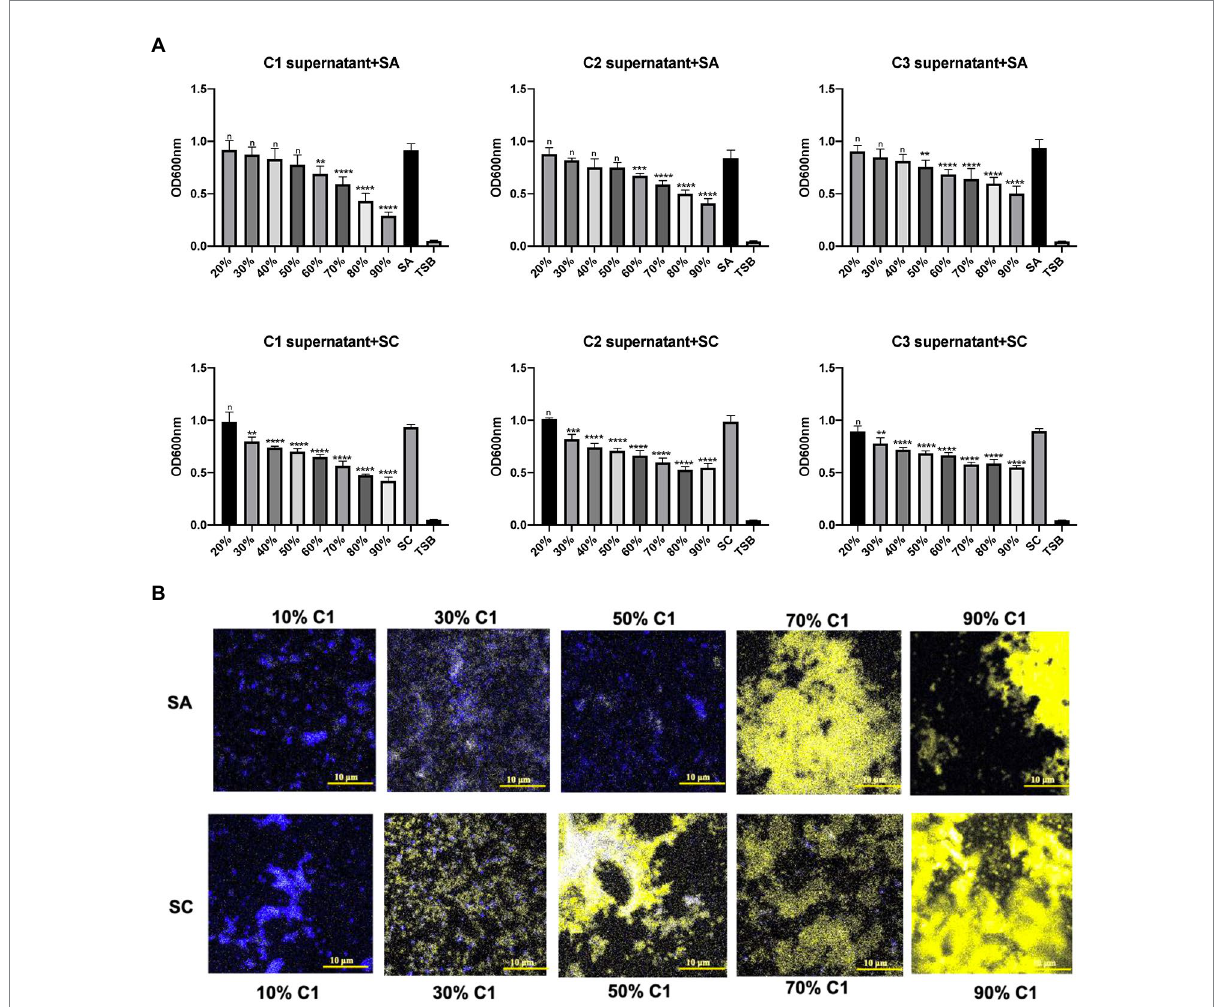
FIGURE 1 Antibacterial effects of Corynebacterium accolens cell-free culture supernatants against planktonic S. aurens. Different concentrations of cell-free culture supernatants from 3 clinical isolates of C. accolens were added to treat planktonic SA and SC. (A) OD 600 was measured to determine the bacterial growth after 24 h treatment. (B) LIVE/DEAD BcalLight Bacterial Viability staining of S aureus planktonic bacteria was used to show dead (PI, yellow) and live (SYTO ® 9, blue) in samples representatives of each treatment group. C1 supernatant, C. accolens cell-free culture supernatants from C. accolens clinical isolate 1. C2 supernatant, C. accolens cell-free culture supernatants from C. accolens clinical isolate 2. C3 supernatant, C. accolens cell-free culture supernatants from C. accolens clinical isolate 3. SA, S. aureas ATCC 51650. SC, S. aureas clinical strain. Significance was determined by comparing the OD 600 value of each treatment group with SA or SC untreated group. ** p < 0.001, *** p < 0.001, **** p < 0.0001. n, no significant difference. Experiments were performed three